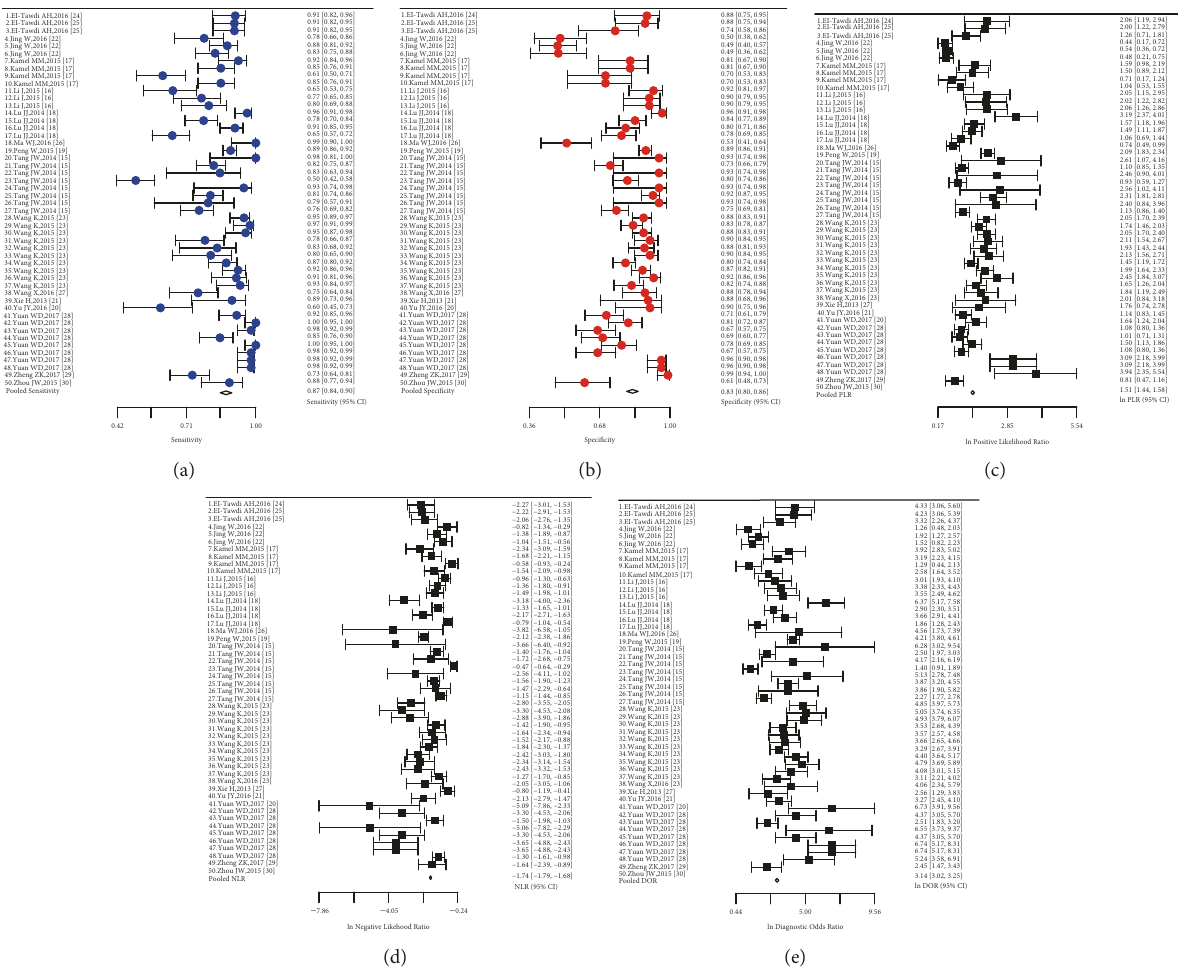
Figure 3: Forest plot. (a) The pooled sensitivity: 0.87(0.838-0.897); (b) the pooled specificity: 0.829(0.794-0.86); (c) the pooled lnPLR: 1.51(1.44-1.58); (d) the pooled lnNLR: -1.74(-1.79- -1.68); (e) the pooled lnDOR: